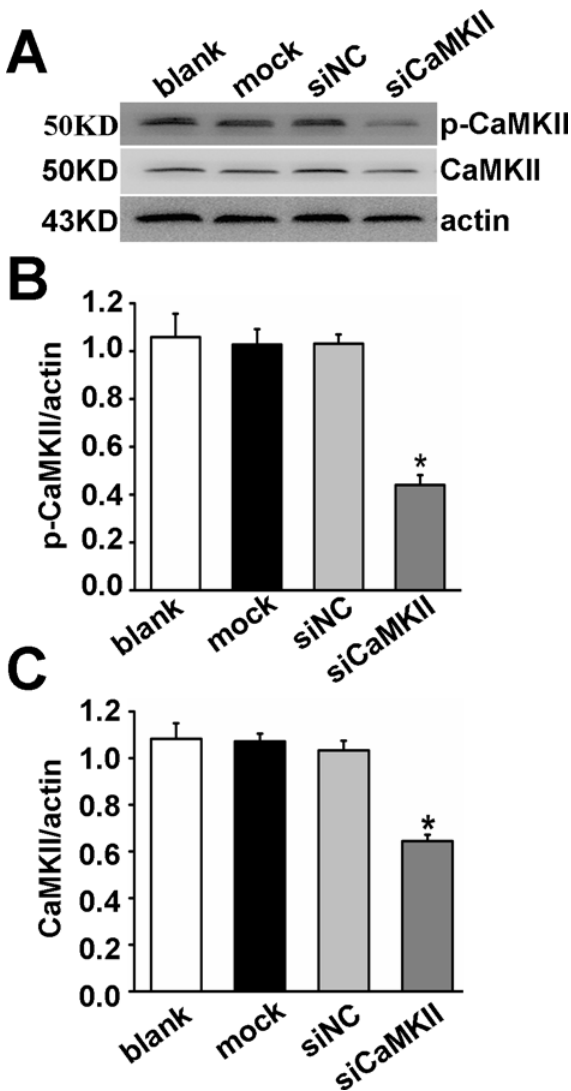
interfering RNA control (siNC), and siRNA targeted to CaMKII (siCaMKII). (B, C) p-CaMKII and CaMKII expressions of cells treated with siCaMKII were significantly inhibited (P < 0.05, n = 5). * P < 0.05 versus